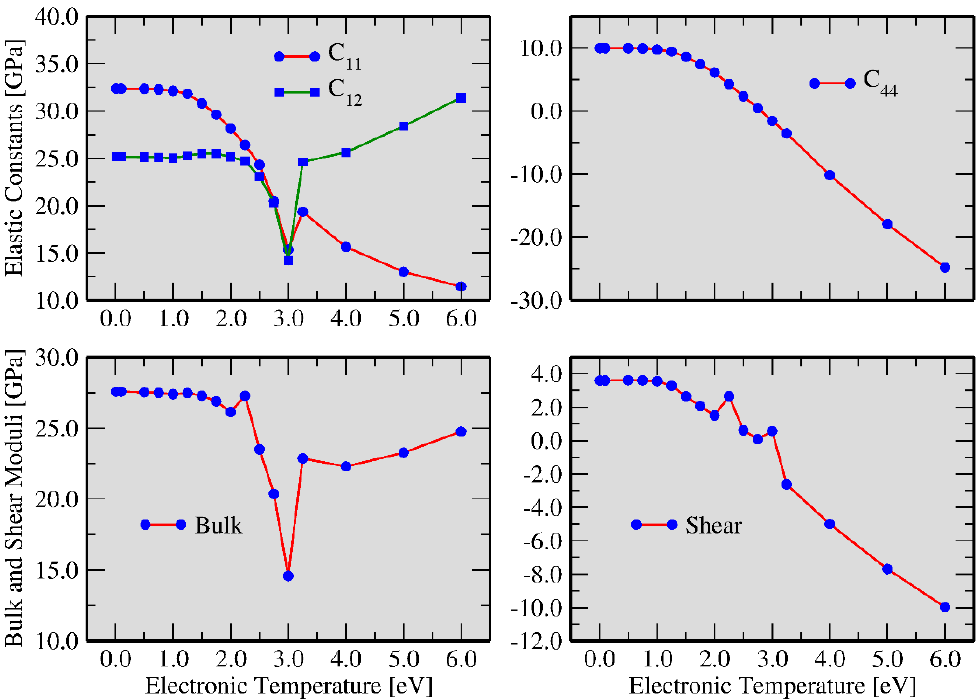
Figure 2. Calculated elastic constants ( top panels), bulk and shear modulus ( bottom panels) as a function of the electronic temperature. The C 11 , C 12 and C 44 elastic constants correspond to the AgBr-cubic face centered structure.